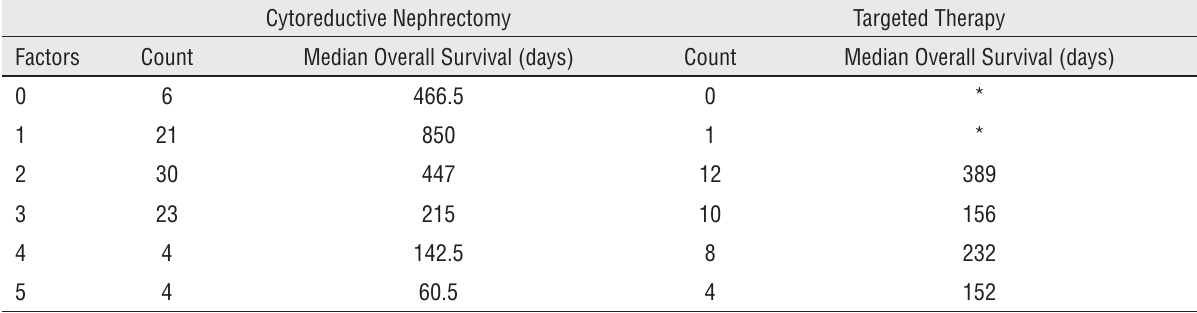
Table 3 - kaplan-Meier analysis with median overall survival for both the cytoreductive nephrectomy and targeted therapy groups stratified by number of risk